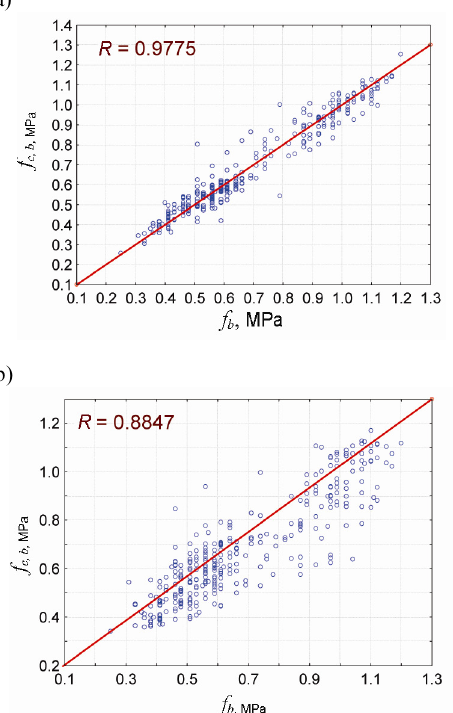
Fig. 10. Correlation between pull-off adhesion f b experimentally determined by seminondestructive pull-off method and pull-off adhesion f c.b identified by network C in training for data acquired by three nondestructive techniques (a) and by two nondestructive techniques (b)